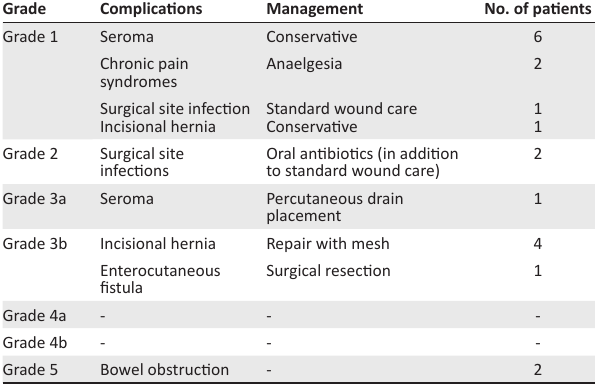
TABLE 2: Surgical complications (early or late) Clavien–Dindo classification system.